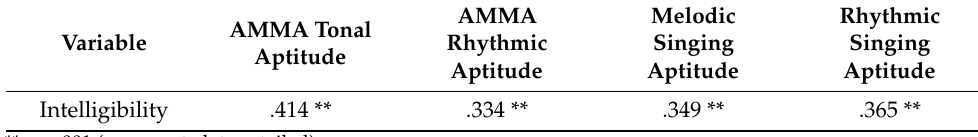
Table 2. The correlations between the intelligibility measure and the musical variables.